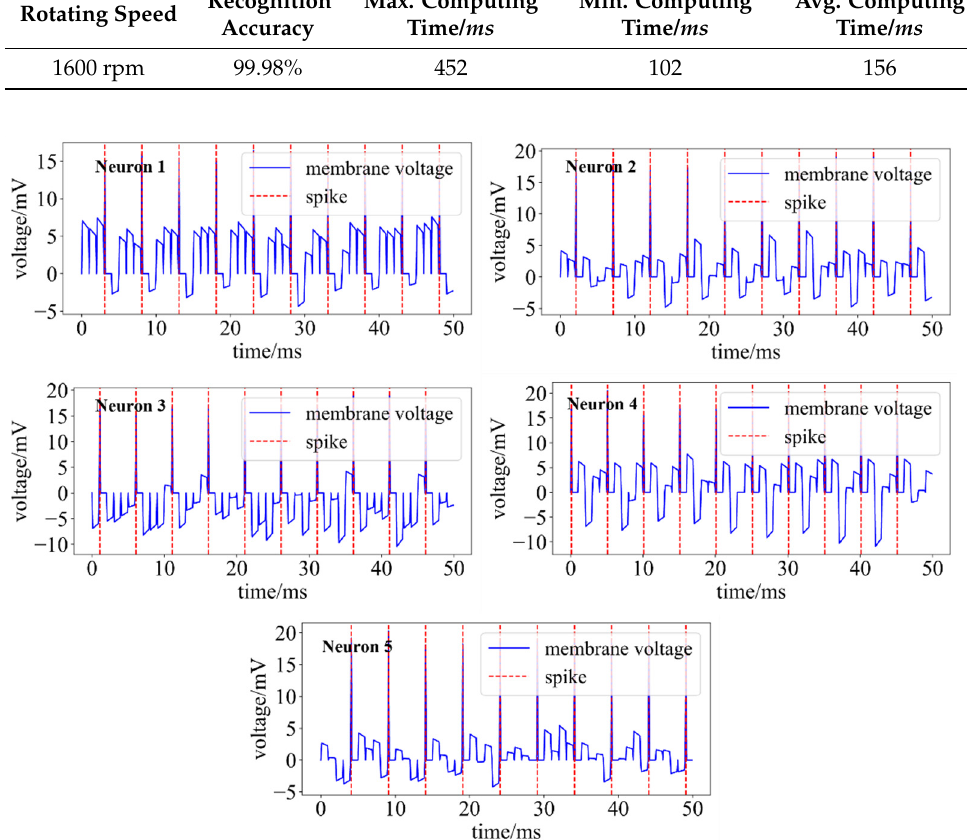
Figure 11. Membrane voltages of five neurons in the output layer. It takes one time step (1 ms) to recognize an input, and the neuron representing the recognition result will fire a spike. Additionally, the membrane voltage is reset to V reset (0 mV ) at each time step to eliminate the memory of the previous input.